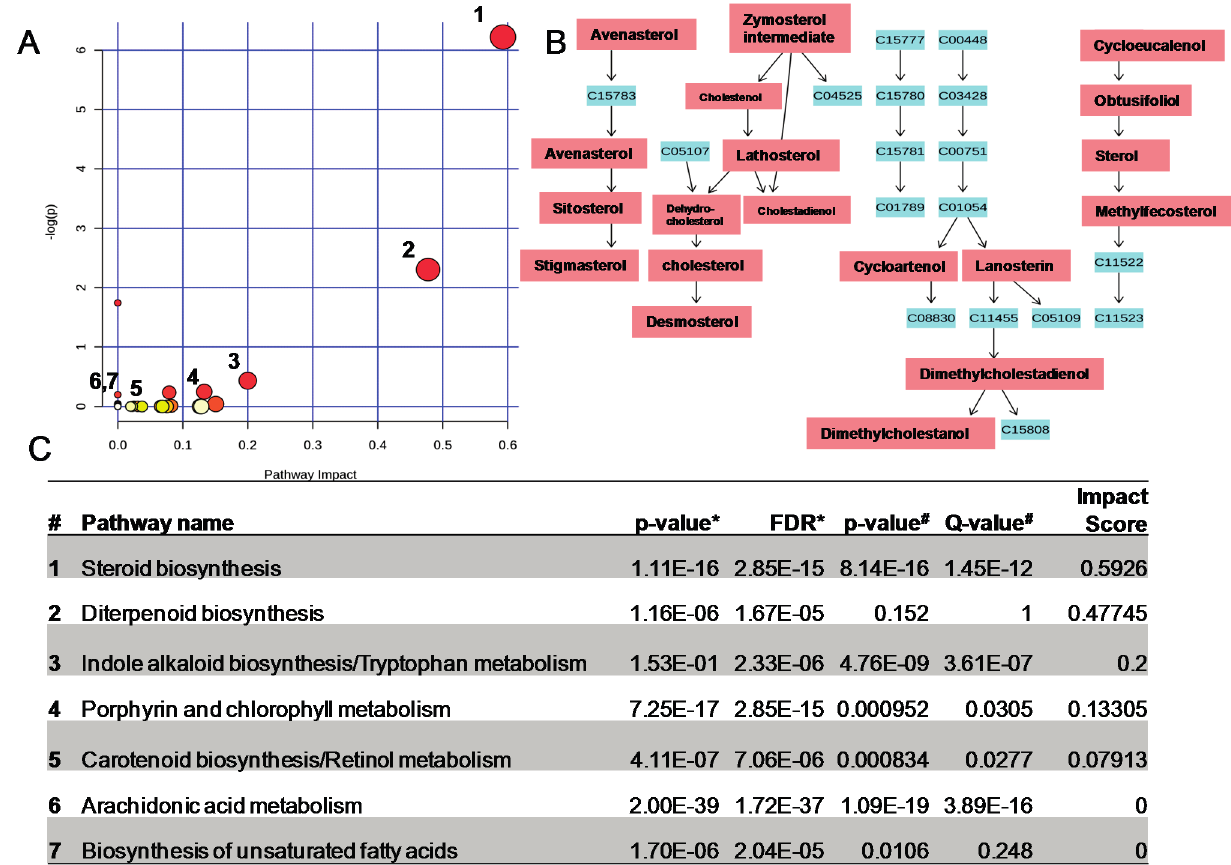
Figure 4. ( A ) Summary of pathway analysis offers a metabolomics view, which displays all matched pathways as circles. The color and size of each circle is based on the p value and pathway impact value, respectively. Please refer to Table S2 for numerical details; ( B ) Representation of the steroid biosynthetic pathway. In red, the metabolites that increased in broccoli sprouts grown under conditions of continuous light, compared with the metabolites in sprouts grown under conditions of continuous dark. In blue, the KEGGS numbers are reported for each metabolite in the same pathway that do not appear to be altered; ( C ) Summary of the major metabolic pathways altered in broccoli sprouts grown under conditions of continuous light, compared with the metabolites in sprouts grown under conditions of continuous dark. False Discovery Rate (FDR * ) and p -value * from MPINet [29]; p -value # and Q -value # from IMPaLA [30]; impact scores for the topological analysis using relative betweeness centrality from MetPA